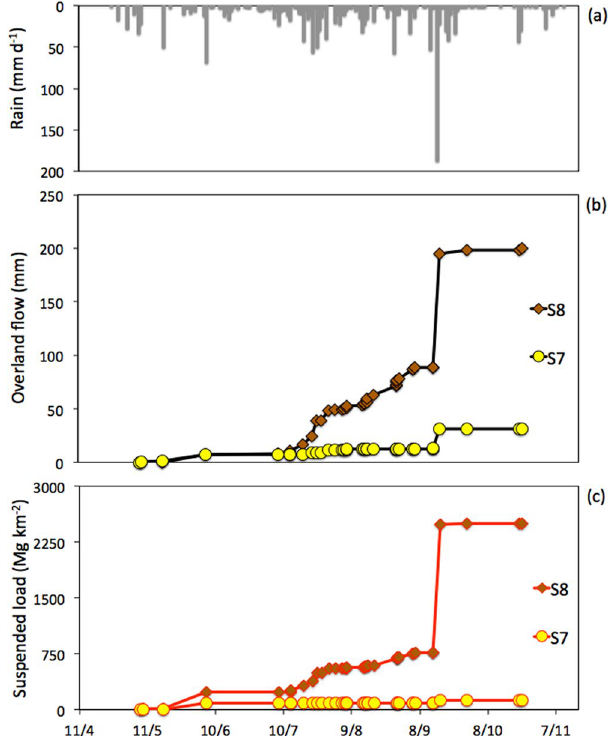
Figure 3. ( a ) Daily rainfall depth, ( b ) cumulated suspended sediment yield and, ( c ) overland flow measured in 2014 at the hydrological station installed at the outlet of two zero-order headwater subcatchments (i.e. ephemeral flow): S7 (dominance of traditional shifting cultivation mosaics); S8 (dominance of teak plantations). This graph was created using Excel 14.0